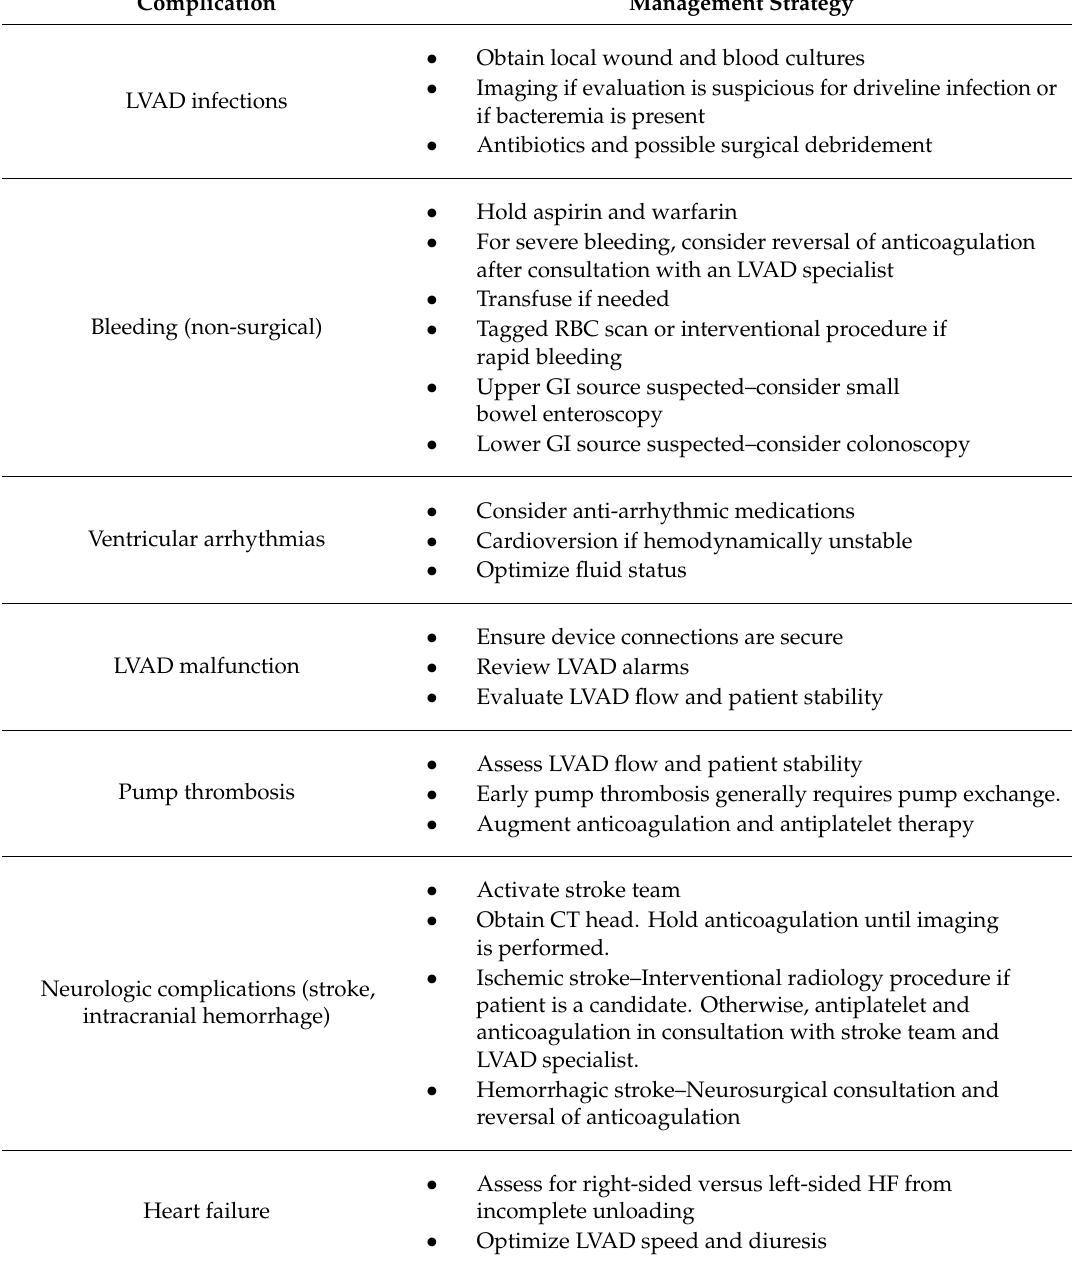
Table 4. Summary of common LVAD-related